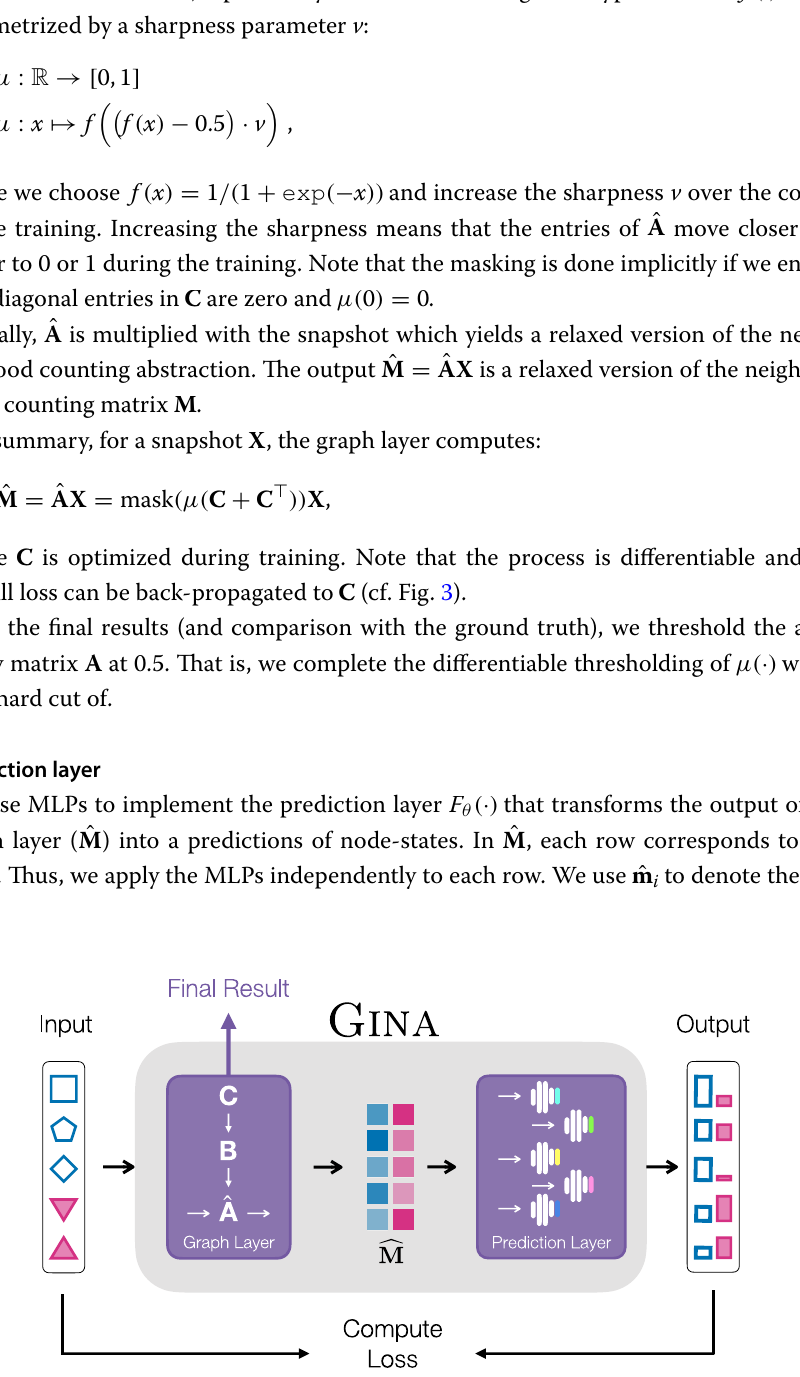
Fig. 3 Illustration of GINA . Snapshots are processed independently. Each input/snapshot associates each node with a node state (blue, pink). The output is a distribution over states for each node. During training, this distribution is optimized w.r.t the input. The output is computed based on a multiplication with the current adjacency matrix candidate (stored as C) and the application of a node-wise MLP. Ultimately, we are interested in a binarized version of the adjacency matrix. Color/filling indicates the state, shape identifies